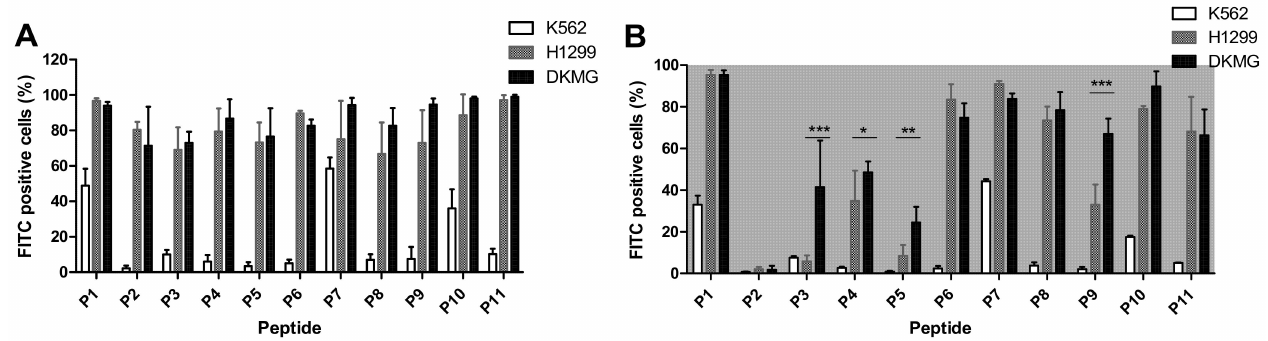
Figure 2. Biological activity of the peptide–FITC conjugates . ( A ) Binding and ( B ) internalization activity of P1-P11 FITC-labeled peptides on K562, H1299, and DKMG cells measured by flow cytome- try. Cells were treated with 2.5 µ M peptide–FITC conjugates and incubation for 3 h at 37 ◦ C before the FACS analysis. The experiments were repeated three times. Mean and ± SD are shown (* p < 0.05, ** p < 0.01, *** p <